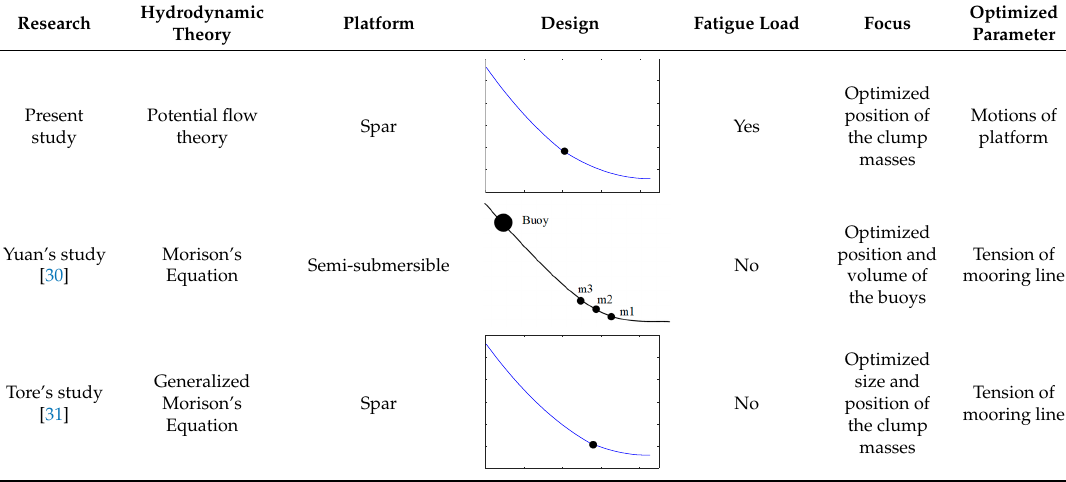
Table 1. Comparison between the present research and that by Yuan [35] and Tore [36].